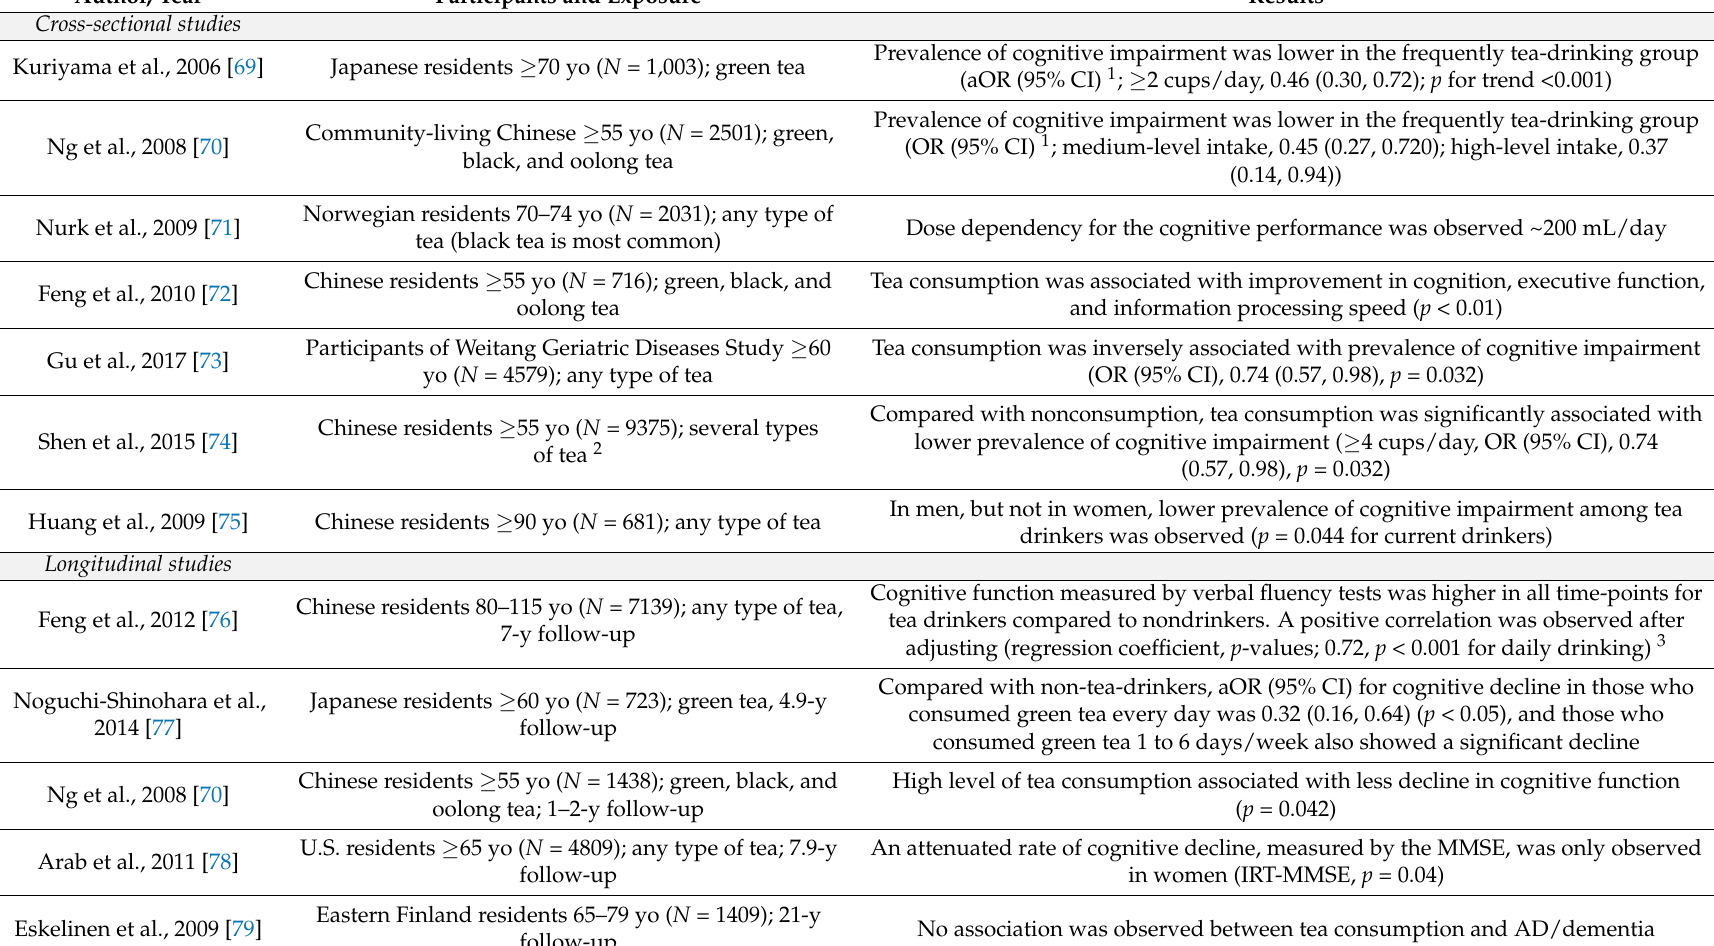
Table 1. Characteristics of cross-sectional and longitudinal